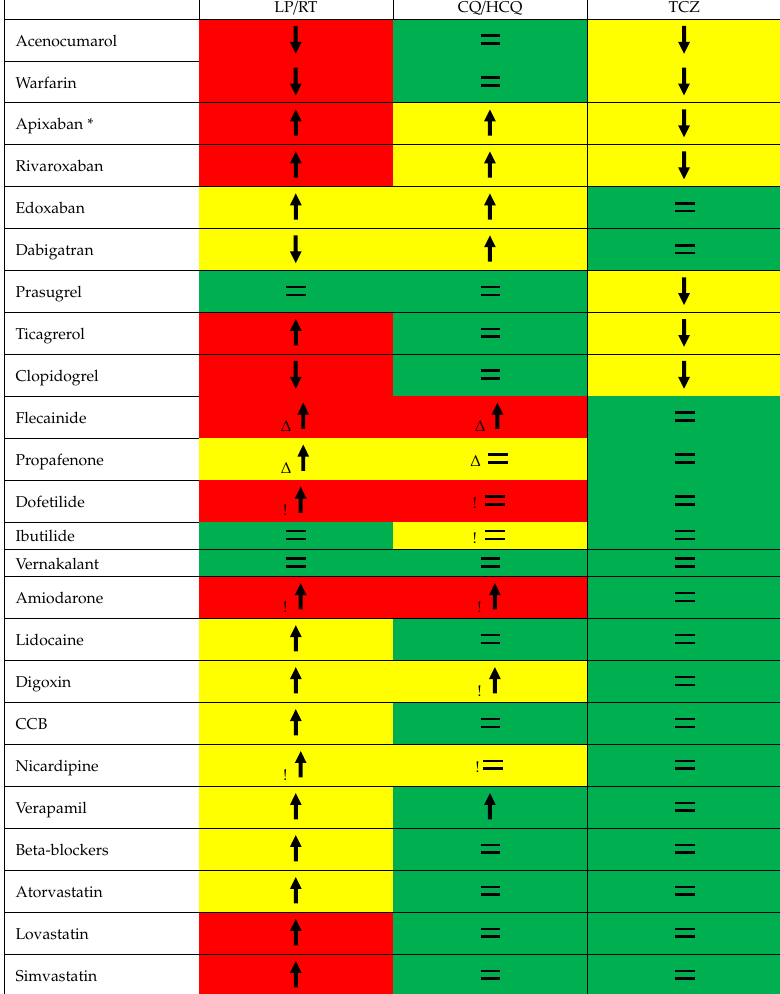
Table 3. Major cardiovascular drug interaction with anti-SARS-CoV-2 drugs.